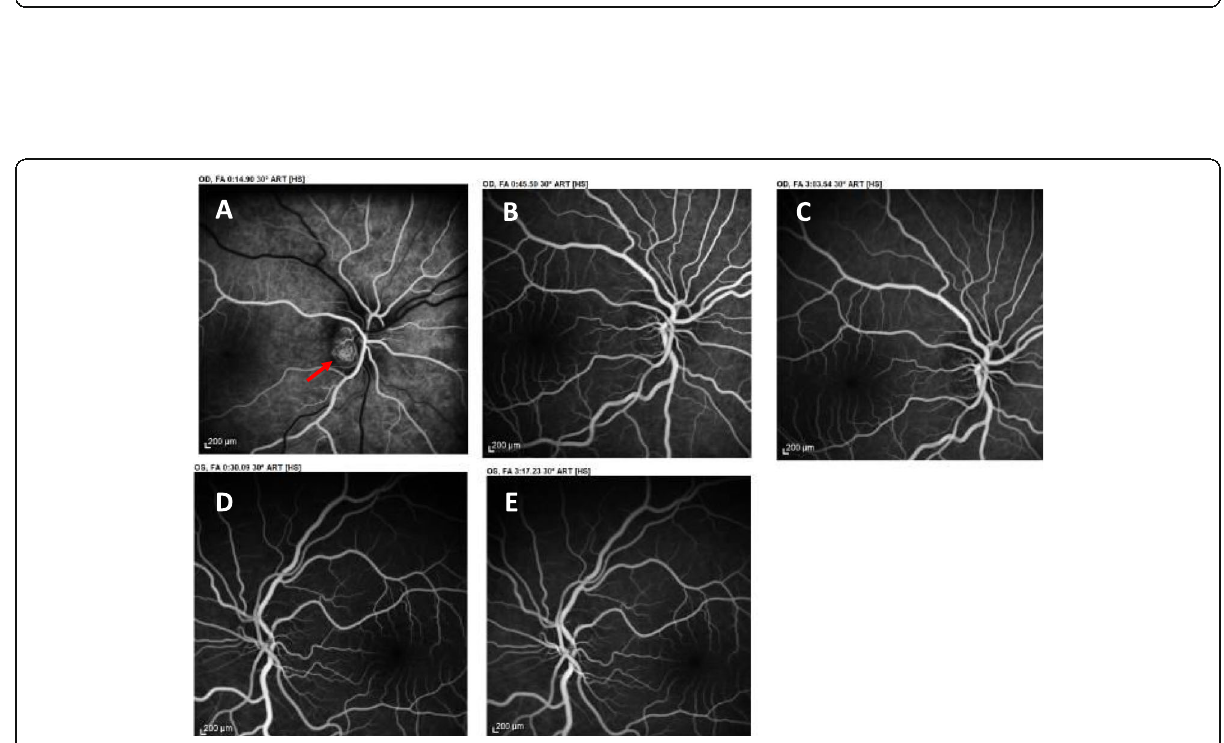
Fig. 2 Fluorescein angiography reveals Optic Disc Drusen ruling out IIH . Arterial phase of FA revealing early nodular staining of the disc due to presence of buried ODD (red arrow) - right eye (Panel a ). No early or late fluorescein leakage suggesting papilledema due to IIH as noted (right - Panel b & c : mid-and late-phase angiography; left- Panel d & e : mid-and late-phase